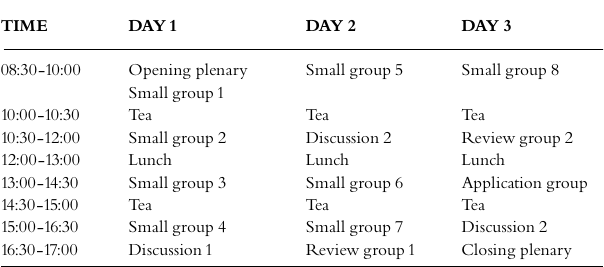
TABLE1 THEGROUPRELATIONSTRAINING EVENT